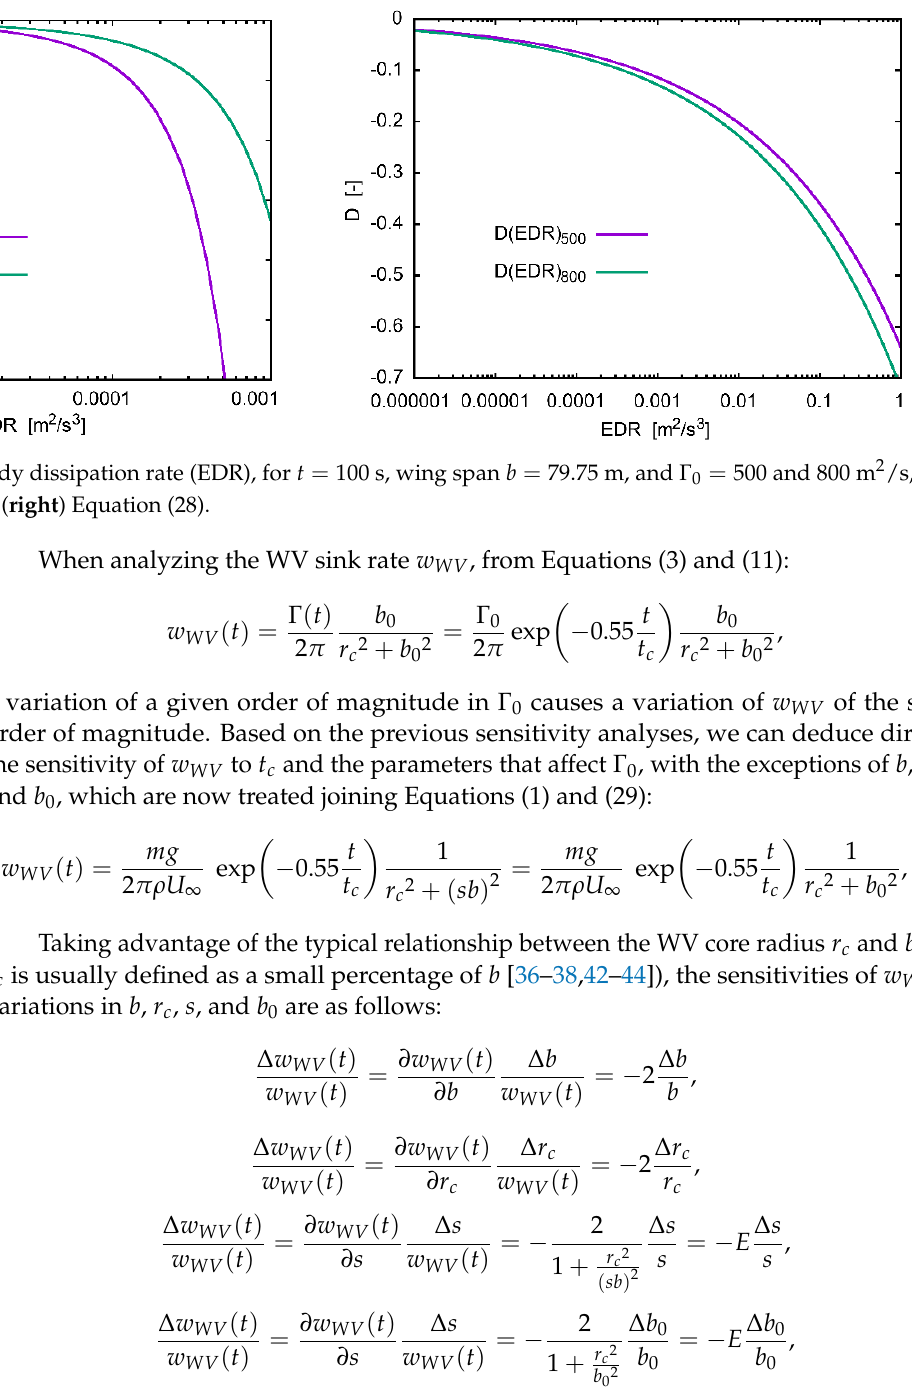
(26) Figure 3. Parameter 𝐶 = 0.55 (𝑡 𝑡 𝑐 ⁄ ) and Γ(𝑡) = Γ 0 exp(−0.55 (𝑡 𝑡 𝑐 ⁄ )) vs. time of the catastrophic wake demise event 𝑡 𝑐 , for 𝑡 = 100 s and Γ 0 = 100 m 2 /s. Regarding the sensitivity of Γ to changes in 𝜀 , since 𝜀 affects the value of 𝑡 𝑐 , as shown in Equations (4) to (7): •